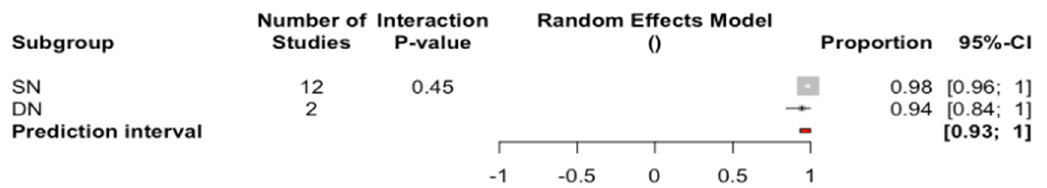
Figure 2. Forest plot of root canal location success rate between the studies selected. The horizontal axis expresses the root canal proportion success rate of each study.